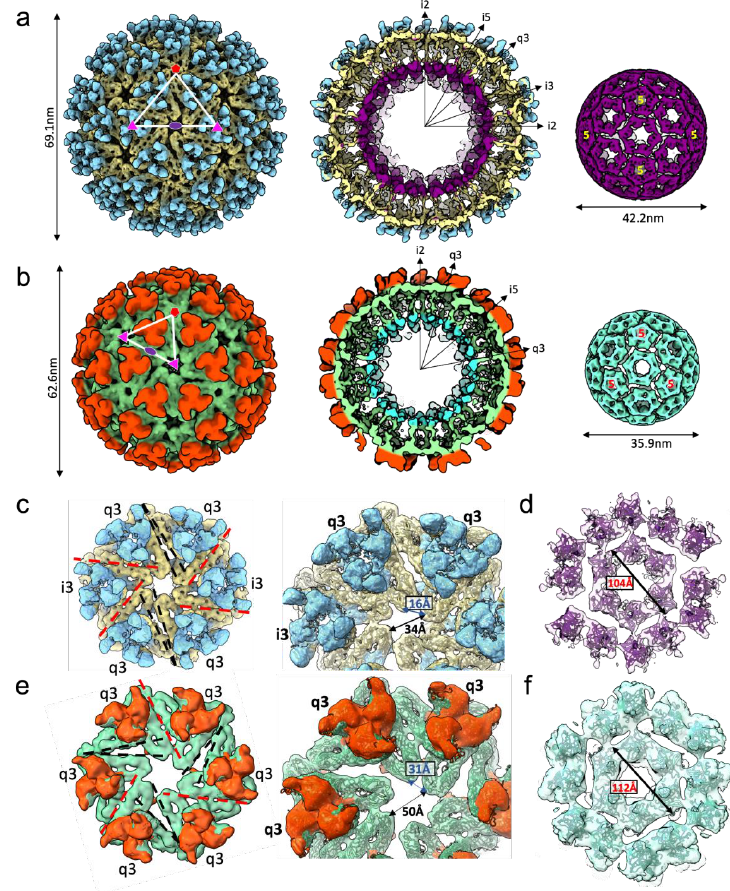
Figure 2. Cryo-EM structures of two icosahedral EEEV particles. Single-particle cryo-EM structures of EEEV ( a ) T = 4 and ( b ) T = 3 icosahedral particles, with radial-colored density map, half-cut representation and extracted NC density displayed left-to-right. 5-fold (red pentagon), 3-fold (pink triangle), and 2-fold (purple oval) symmetry axes labeled. ( c ) T = 4 glycoprotein hexamer density computationally extracted from the map (E2: blue, E1: khaki) with a zoom-in view on the right. Type I (extensive lateral contacts-red) and type II (limited angular contact-black) interfaces are labeled within the hexamer assembly. ( d ) T = 4 NC density (purple) around the hexamer assembly displayed with a rigid-fit of an atomic model of Cp C-terminal domain. ( e ) T = 3 glycoprotein hexamer density (E2-orange, E1-green) with a zoom-in view on the right and ( f ) T = 3 NC density (aqua) around hexamer with interfaces and distances labeled. PDB model 6MX4 rigid fit into density maps ( c – f ).